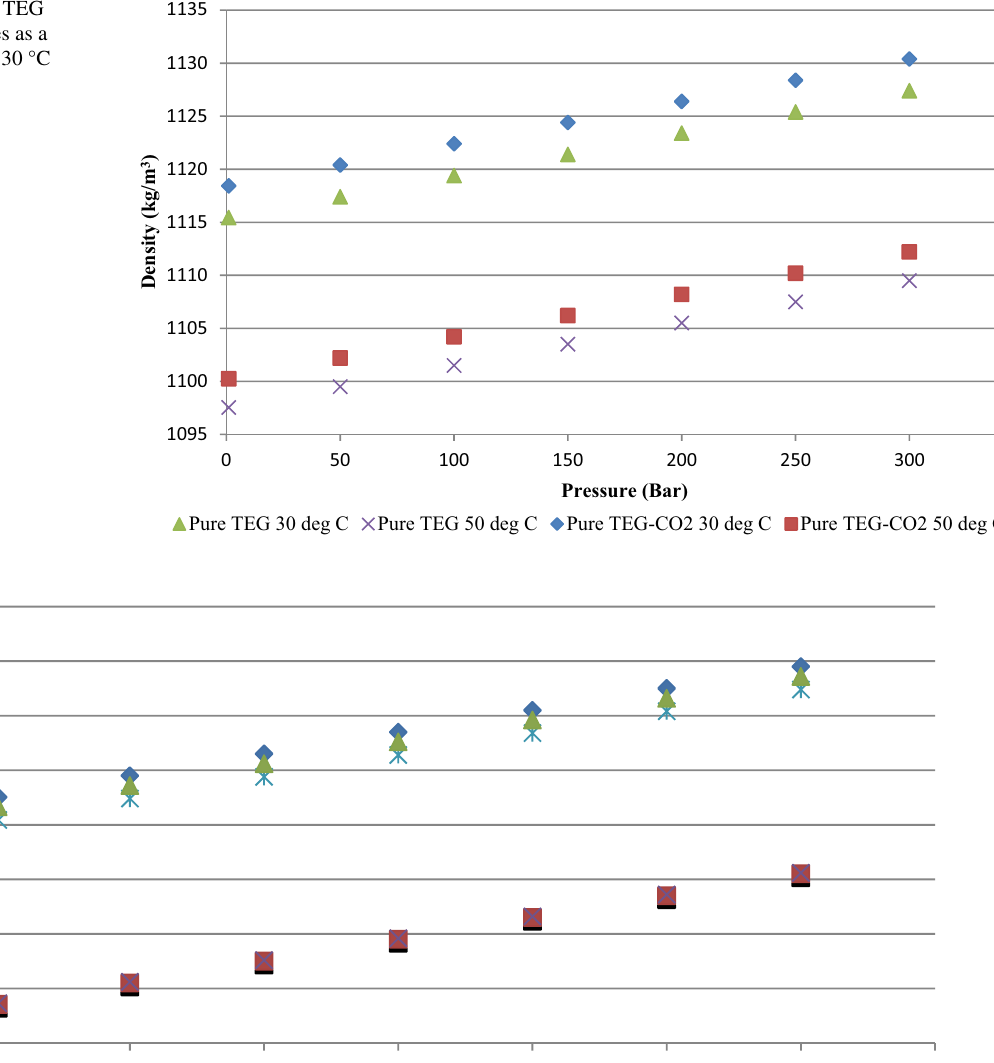
Fig. 3 Density of Pure TEG and TEG–CO 2 mixtures as a function of pressure at 30 °C and 50 °C